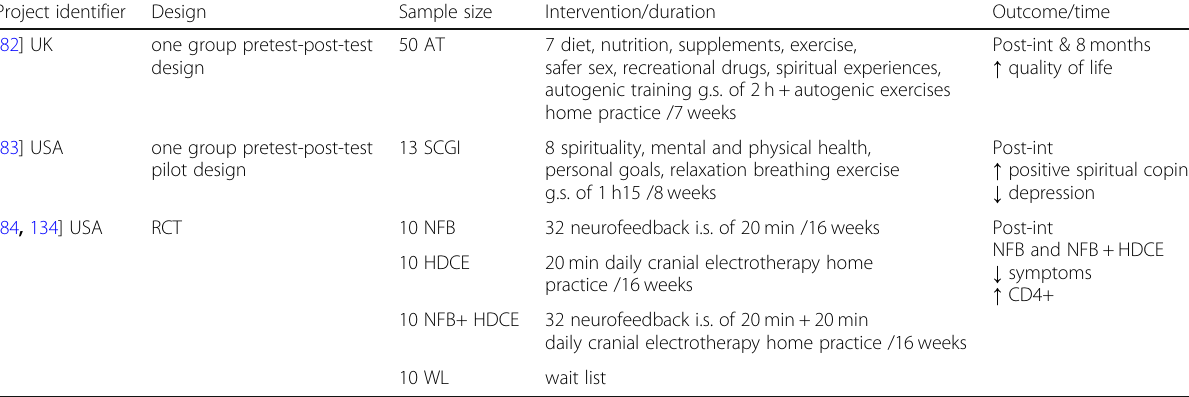
Table 9 Autogenic training, breathing and neurofeedback included studies Project